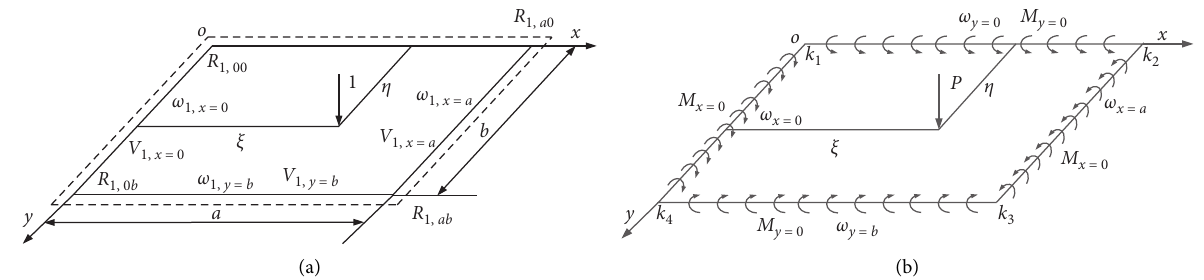
Figure 2: The force systems based on reciprocity theorem. (a) Basic system and (b) actual